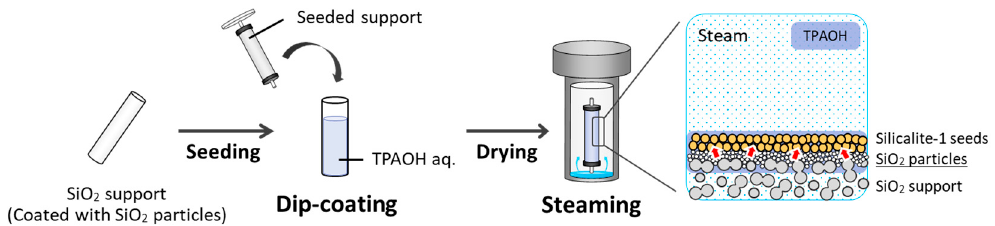
Figure 1. Schematic of process for synthesizing silicalite-1 membranes using the gel-free SAC method.